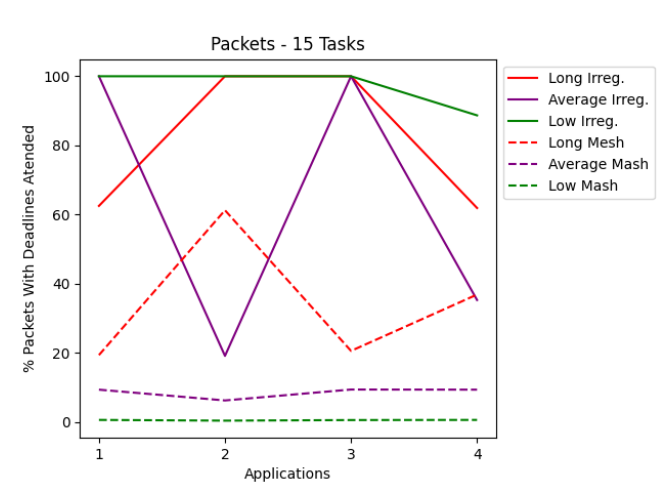
Figure 9. Packets for applications with 15 tasks. Table 3. Irregular topologies with 10 cores.